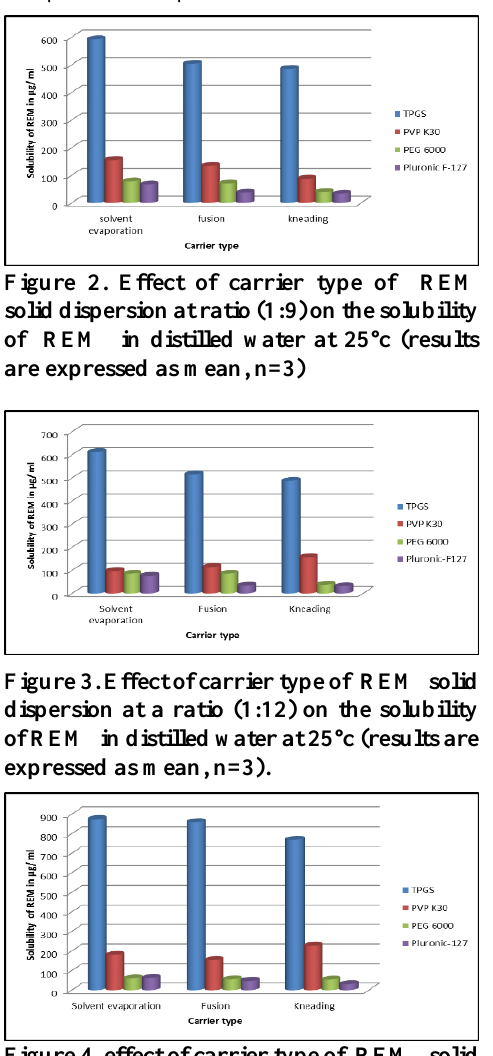
Figure 4. effect of carrier type of REM solid dispersion at a ratio (1:15) on the solubility of REM in distilled water at 25°C (results are expressed as mean,